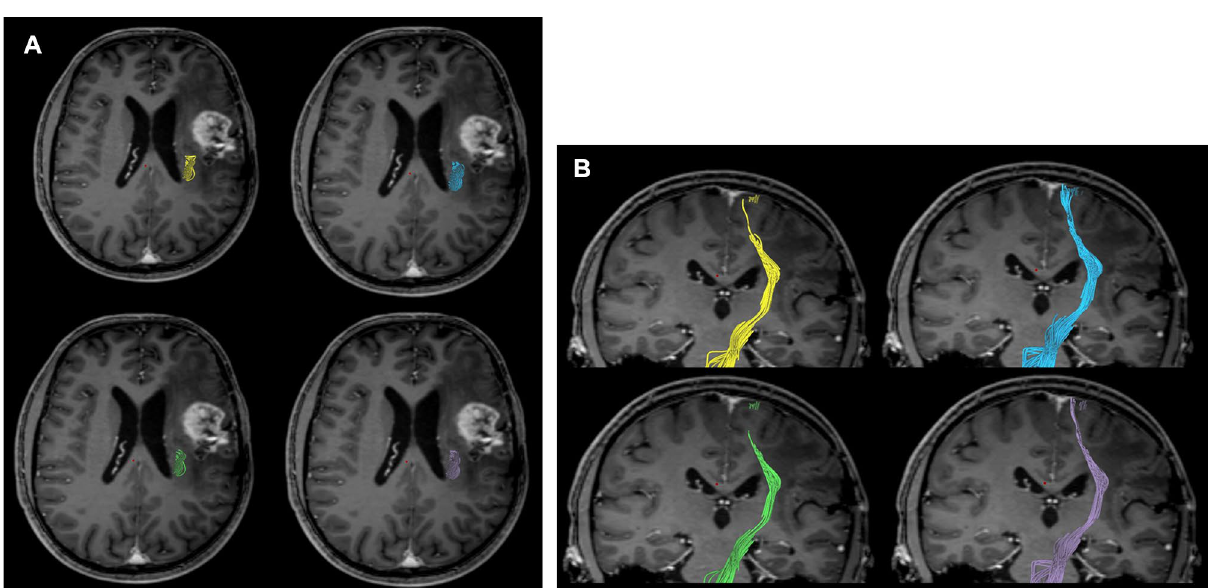
Figure 3. ( A ) Anatomic ROI based tractography at 50% FAT (yellow) and 75% FAT (green) and nTMS based tractography at 50% FAT (blue) and 75% FAT (purple). Axial views are displayed in ( A ), coronar views in ( B ) of the same